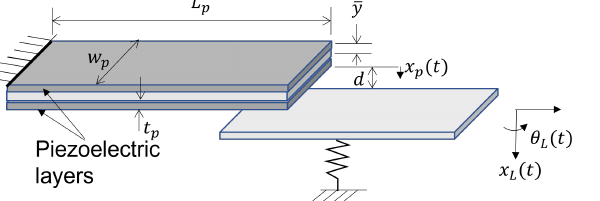
Figure 2. Dimensional definitions for piezoelectric bimorph as used in forcing